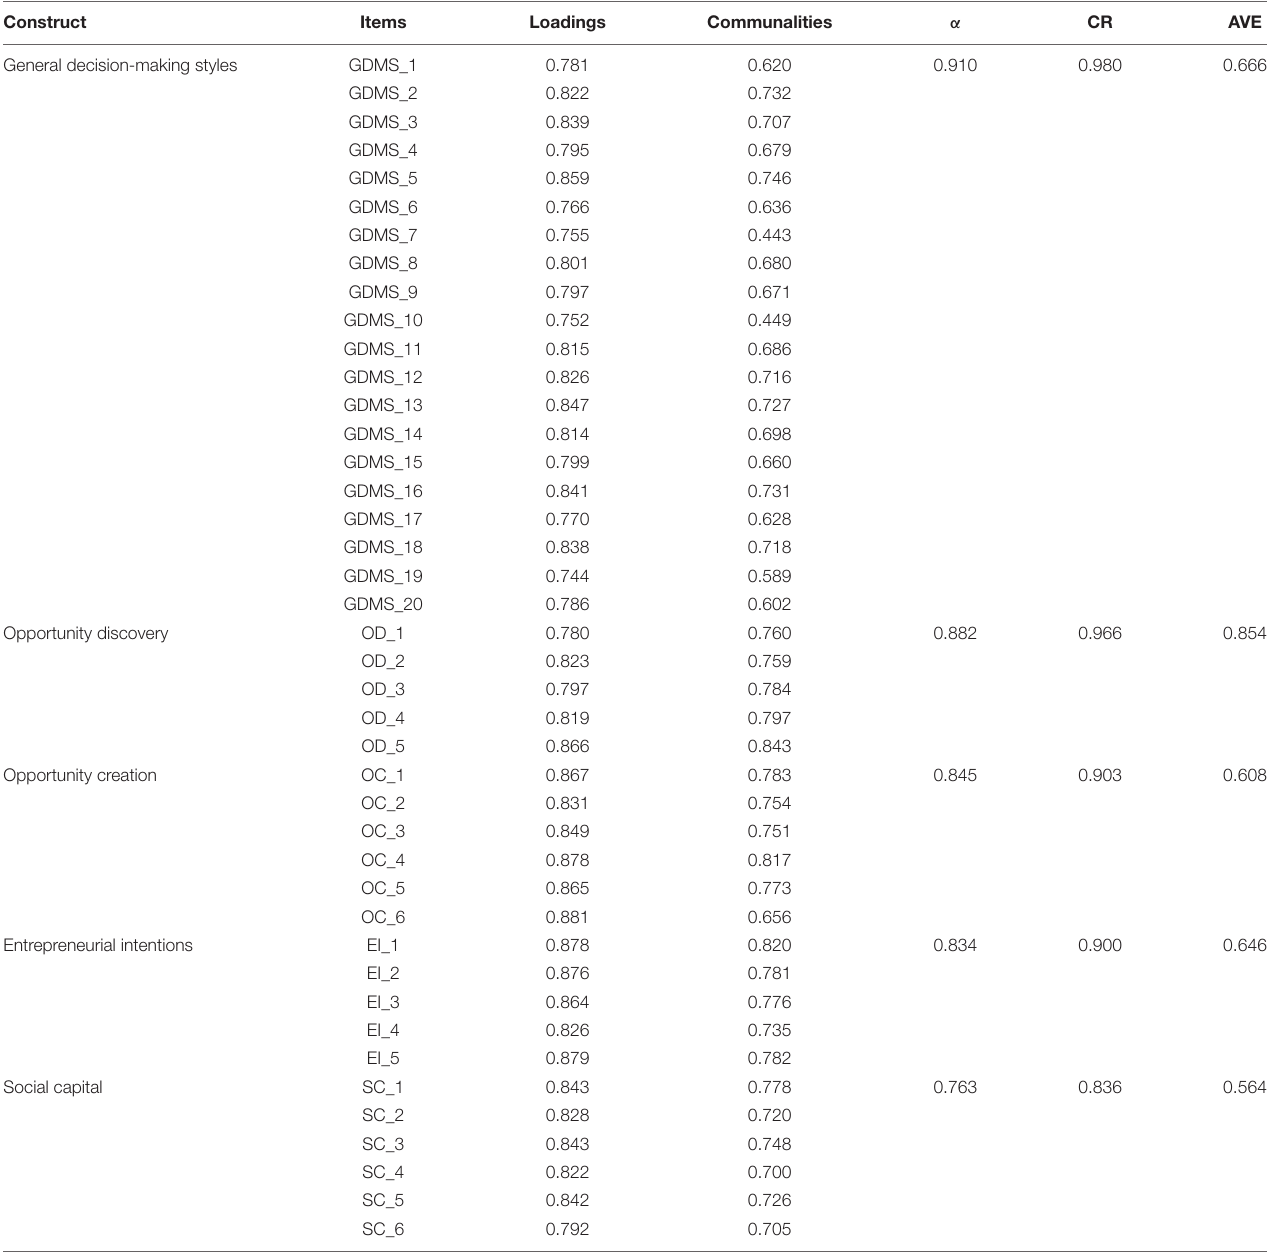
TABLE 2 | Measurement